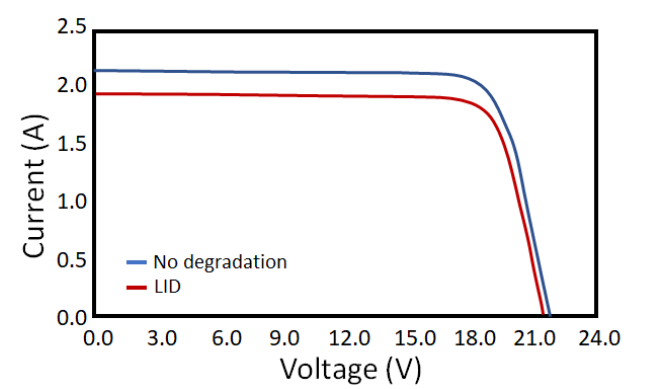
Figure 17. I-V curve of simulated PV module with LID